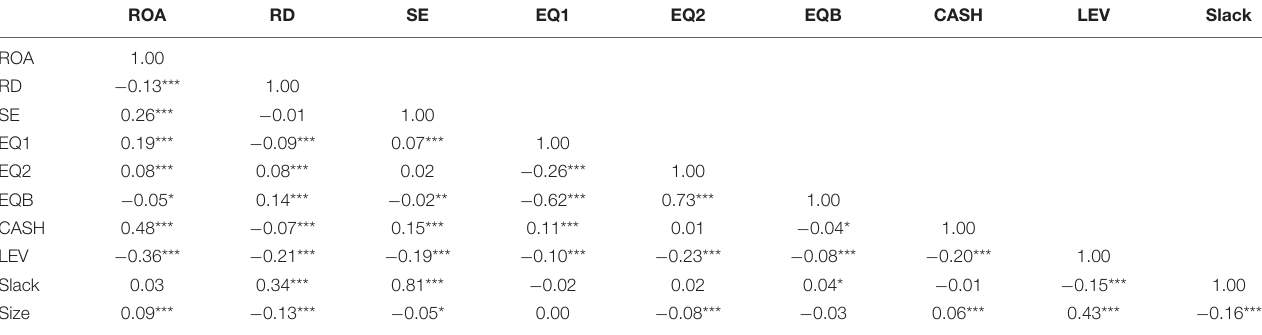
TABLE 2 | Correlations.